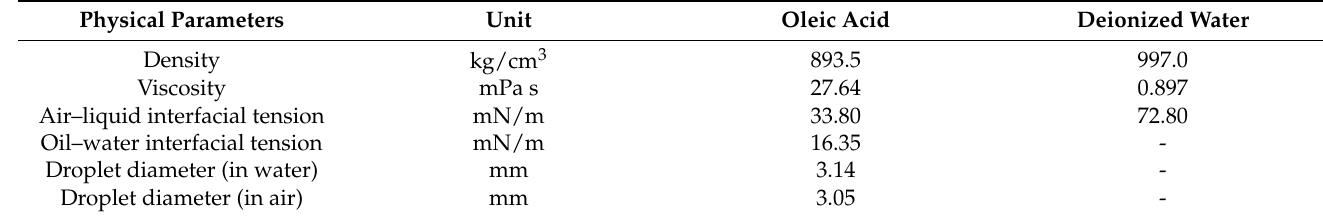
Figure 2. Schematic of the experimental device for studying the spreading behavior of an oil droplet on the Teflon in water [43]. Table 1. Main physical parameters of oleic acid and deionized water (25 ◦